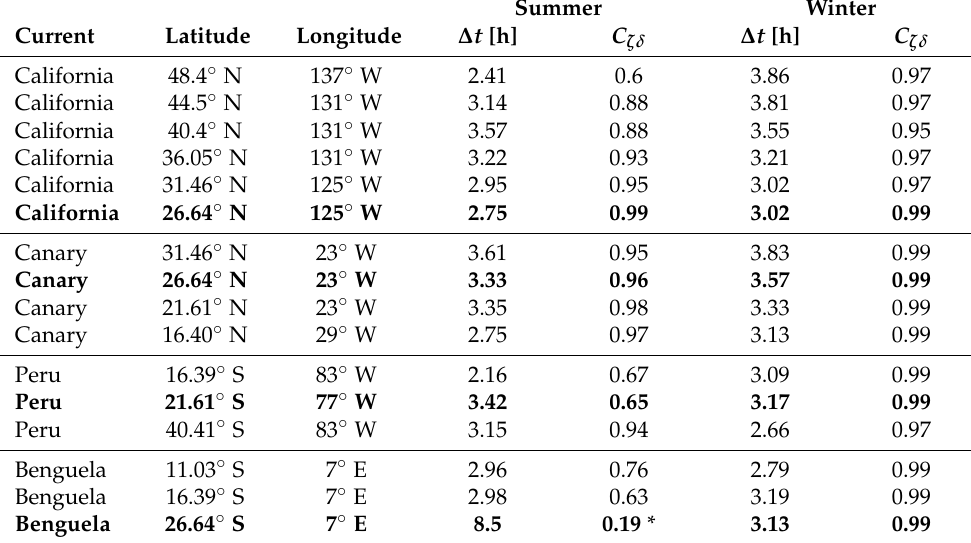
Table 1. Phase difference ∆ t (in hours) between normalized divergence ( δ ) and vorticity ( ζ ) by current, center (latitude, longitude), and season for each quadrangular area examined. The phase difference is the angle of the complex power spectral density, calculated with a 10-day window using Welch’s method [22]. All phase differences correspond to the diurnal (24 h) component. Positive values indicate that divergence occurs first and is then followed by the relative vorticity. Rows in bold mark the study areas compared in this paper. Values with an asterisk (*) correspond to cases when the coherence did not pass the F-test for the 90% confidence interval.